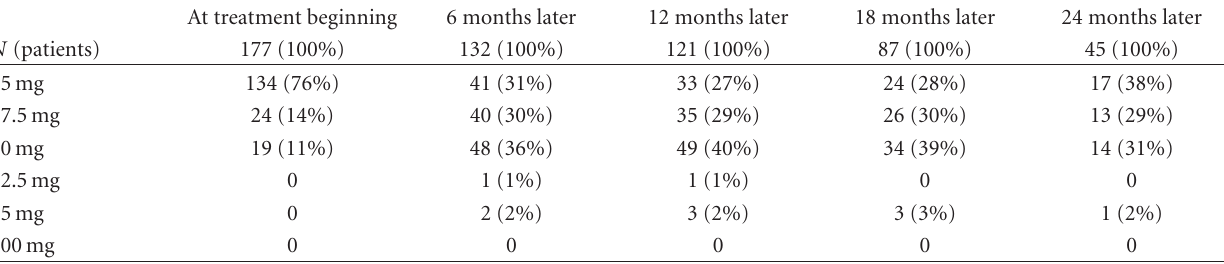
Table 4: RLAI dose distributions in patients beginning with RLAI, and every 6 months onwards. for each patient, the last known observation on dose was carried forward to the time point. Two patients were excluded from the analysis of dose changes at later time points because of missing